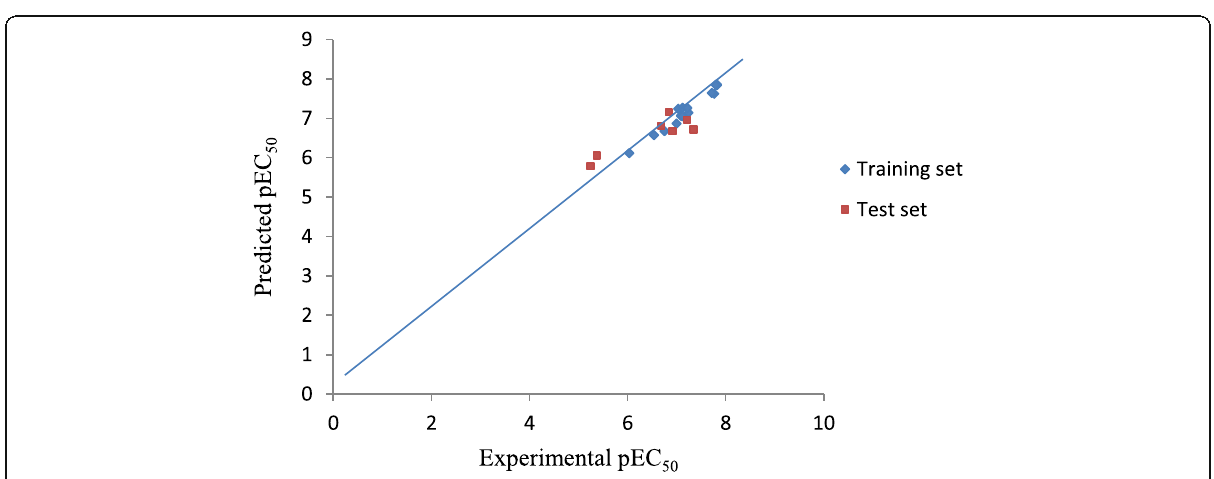
Fig. 1 Plot of predicted activity against experimental activity of both training and test set